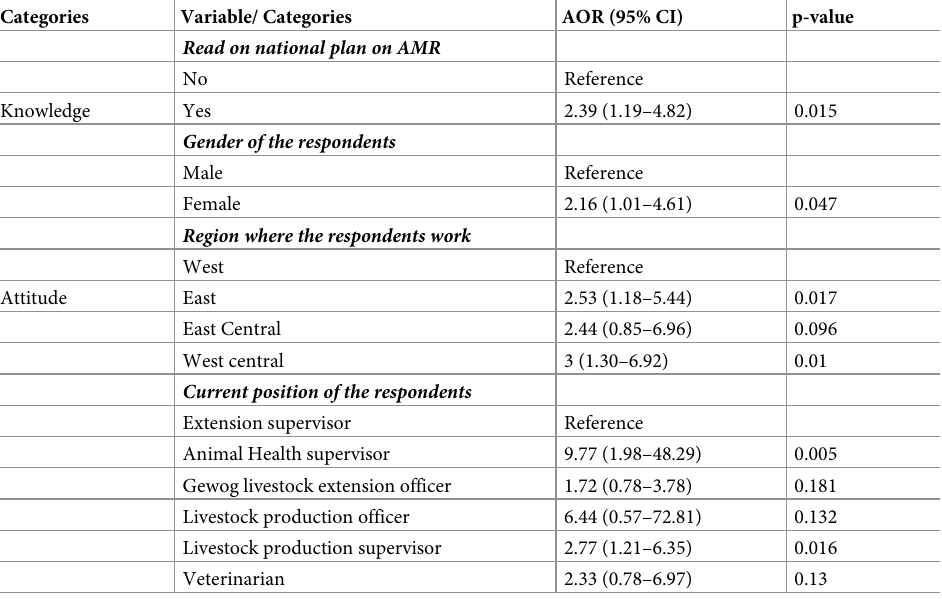
Table 4. Factors associated with good knowledge, attitude and practice on antibiotic use and AMR among the vet- erinarian and para-veterinarians in